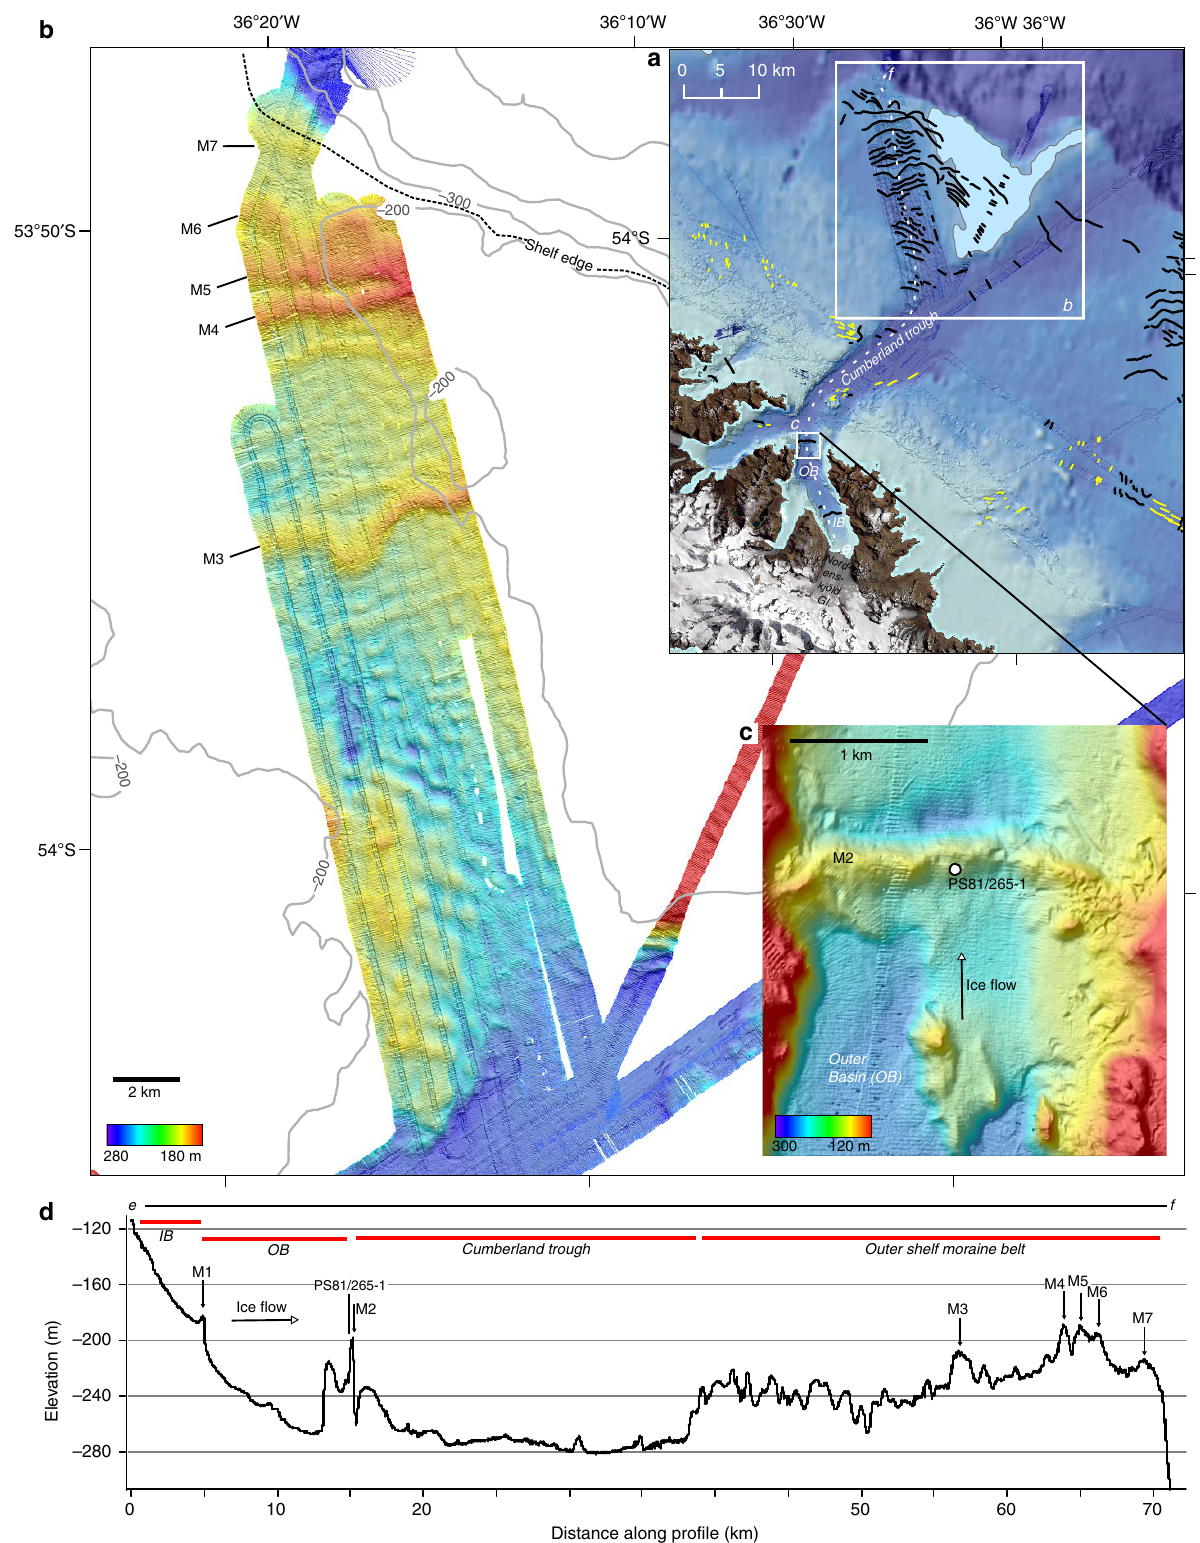
Figure 5 | Atlas Hydrosweep DS-3 multibeam swath bathymetry collected in the secondary trough north of Cumberland Trough. ( a ) Location of the dataset with an overview of mapped bedforms in the system. ( b ) Hillshaded swath bathymetry showing an abundance of sea-bed moraines. Major moraine ridges (M) numbered (M3-M5 interpreted as the LGM extent). ( c ) Kongsberg EM710 multibeam swath bathymetry data from the mouth of Cumberland Bay, showing the cross-trough moraine M2 and the location of a core (PS81/265-1) that targeted the moraine sediments. M2 is interpreted to correspond to the Antarctic Cold Reversal advance. ( d ) Topographic profile from the Nordenskjo ¨ ld Glacier terminus to the outer shelf showing the details of the geomorphology along the former flow line. IB, inner basin; OB, outer